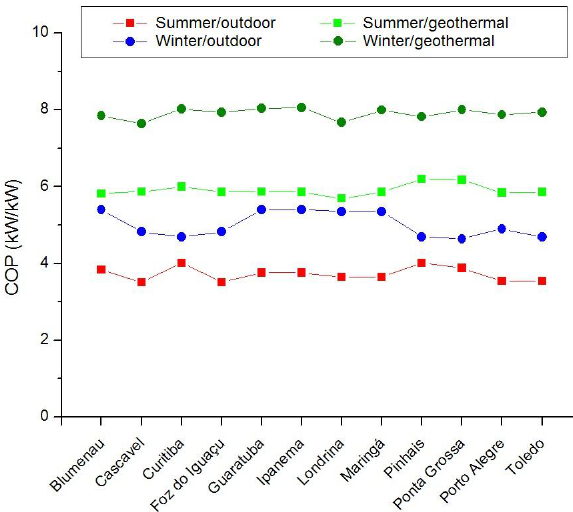
Figure 6: COP values for the measuring stations in alphabetical order.